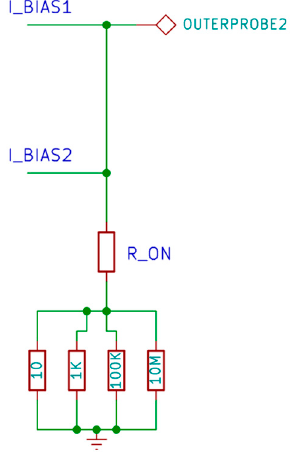
Materials 2017 , 10 , 110